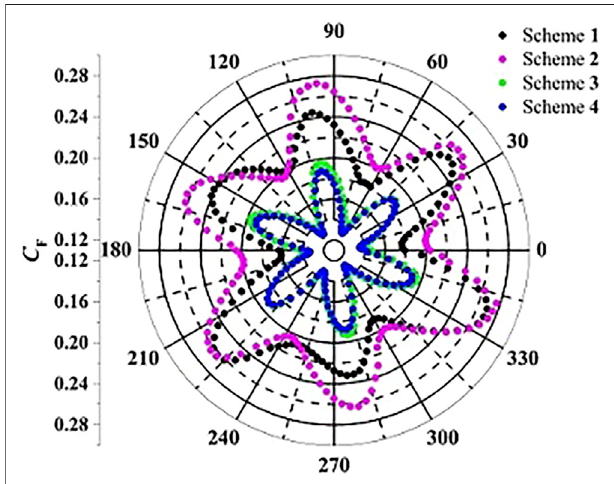
FIGURE 9 | Radial force distribution of each